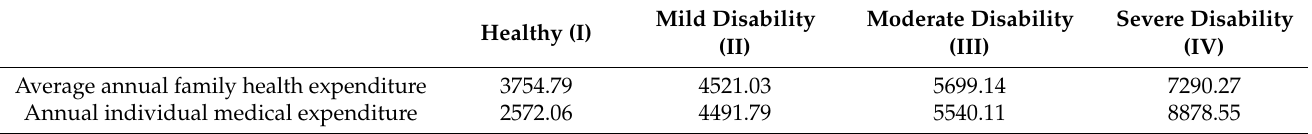
Table 6. Medical expenditure for seniors with different health states in 2015 (unit: